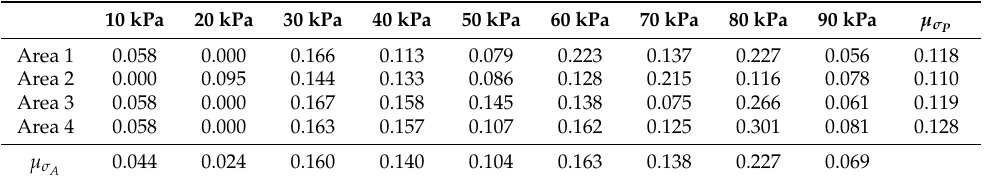
Table 1. Calculation of µ σ and µ σ based on the OFP sensor experimental data from Figure 7, where the former is the average standard deviation of σ V for each pressure over different areas, while the latter is the average standard deviation of σ V over different pressures measured for a given area.